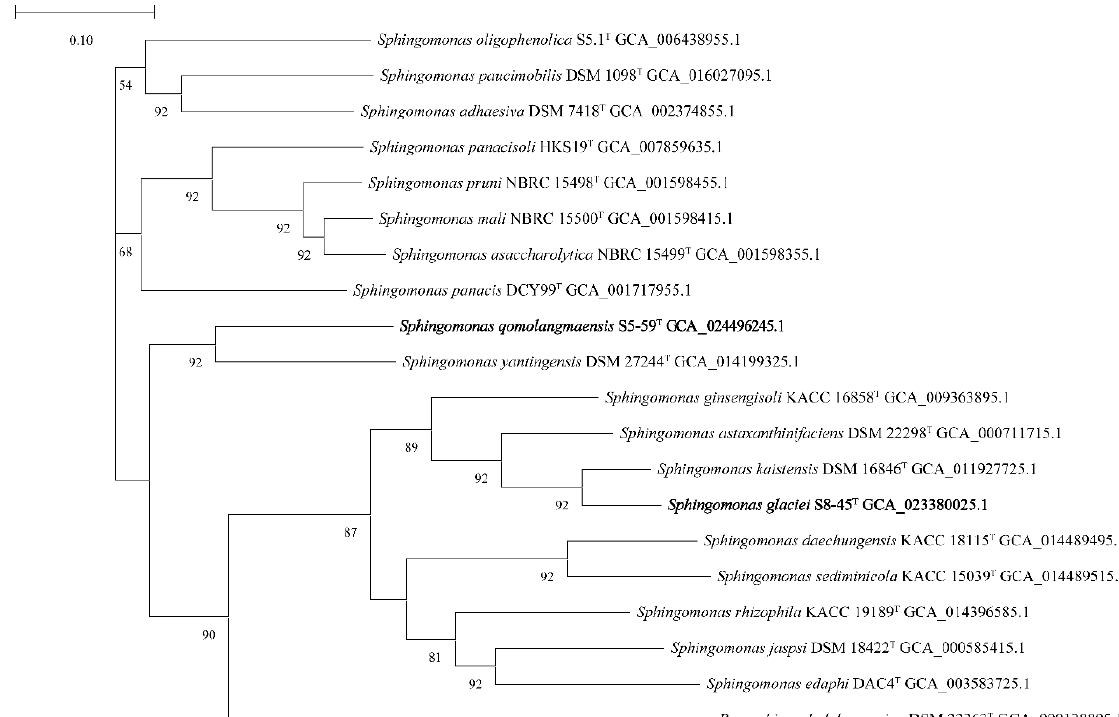
Figure 2. UBCG phylogenetic tree based on the up-to-date core gene set and pipeline of strains S5-59 T , S8-45 T , and strains of other closely related species in the genus Sphingomonas and Parasphingorhabdus . Parasphingorhabdus marina FR1087 T (DSM 22363 T ) was used as an outgroup. Phylogenetic tree generated with UBCG using the amino acids sequences. The number at the nodes indicates the gene support index (maximum value, 92). The numbers at the nodes indicate the gene support index. Bar, 0.10 substitutions per nucleotide position.